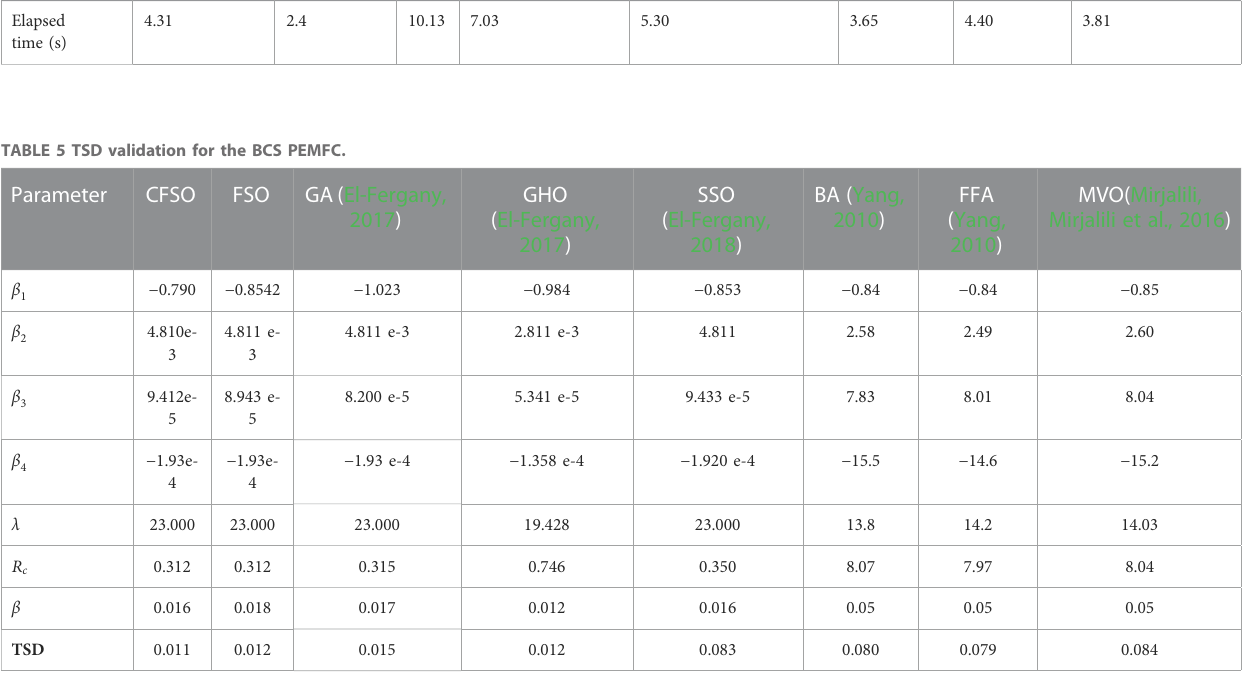
Algorithm (SSA), improved chicken swarm optimization algorithm